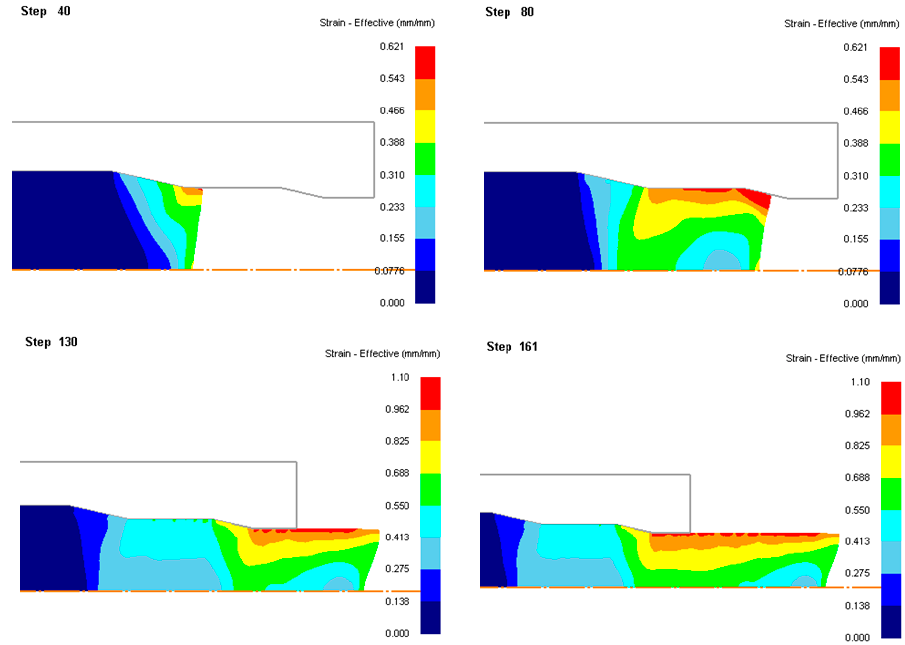
Figure 8. Effective strain distributions in different stages of the simulation used in the validation of the finite element model.